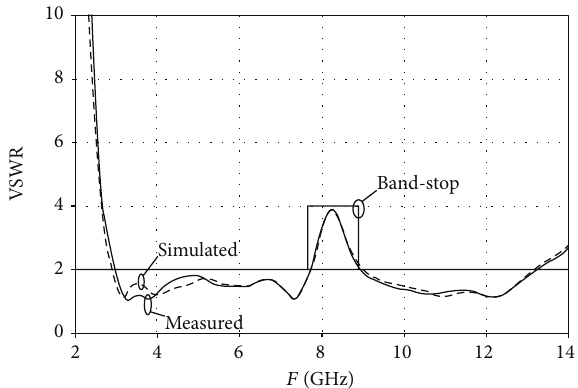
Figure 10: Measured and simulated VSWR of the proposed antenna.